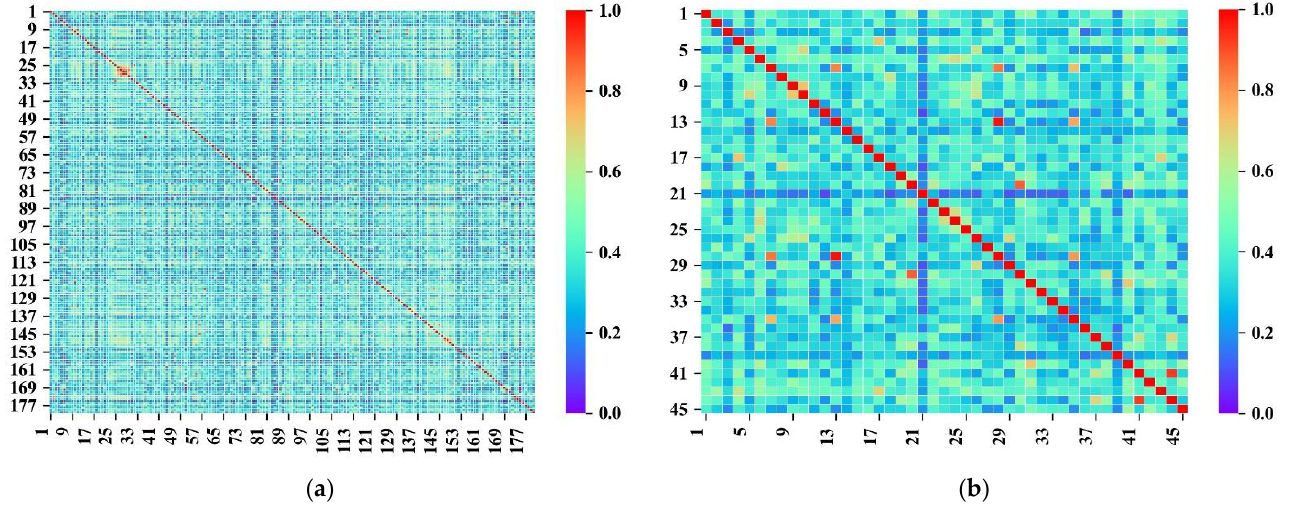
Figure 3. ( a ) Heat map of the Tanimoto similarity index on the training set. ( b ) Heat map of the Tanimoto similarity index on the external validation set.